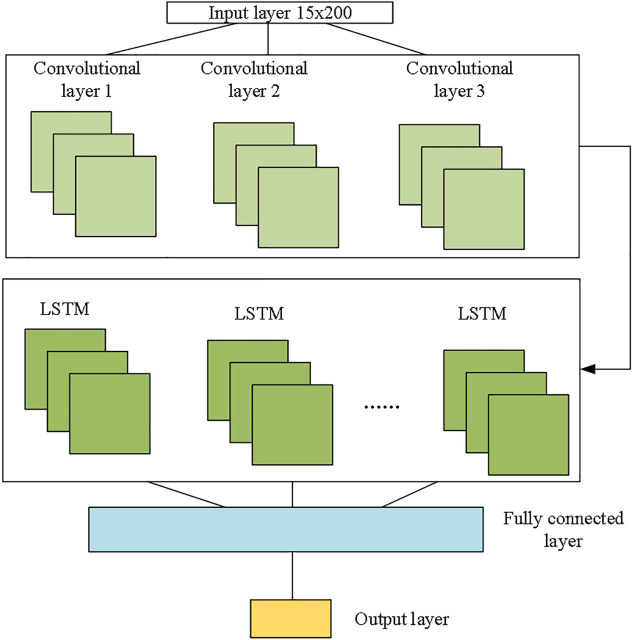
GNN-LSTM translation model.